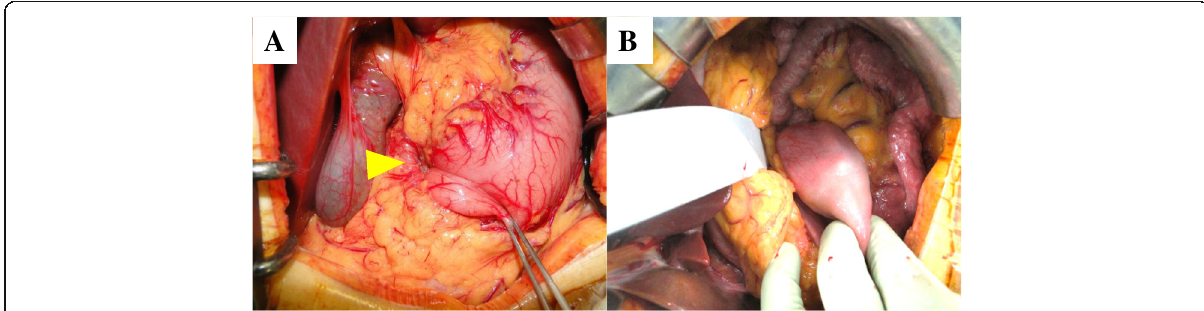
Fig. 4 Intraoperative finding. Open distal gastrectomy was performed. The mass was found in the duodenum 3rd portion and invaginated to the duodenum (arrow) ( a ). We moved it to the stomach and performed distal gastrectomy with B-1 reconstruction ( b